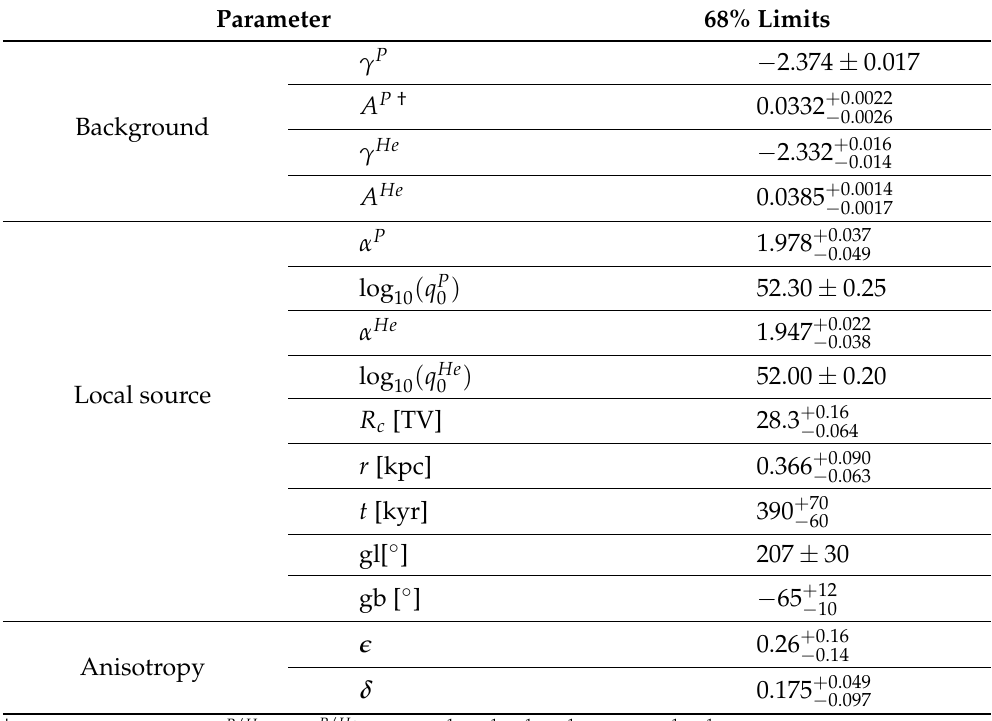
Table 2. Fitted injection parameters of the background and local